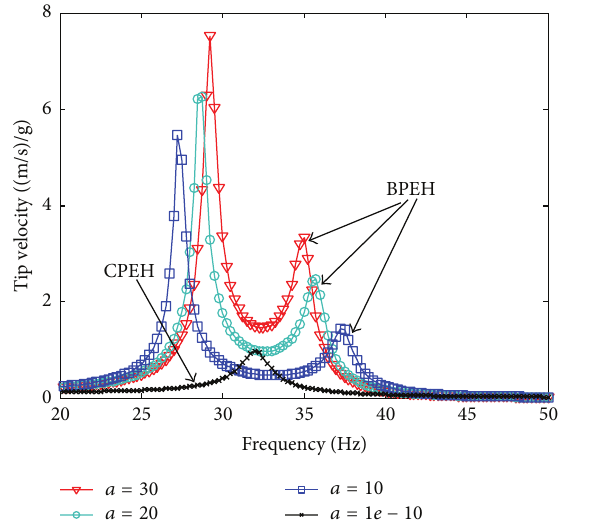
Figure 8: Output power 𝑃 0 with various 𝑎 when 𝑔 = 1 and 𝑅 L = 1k Ω .